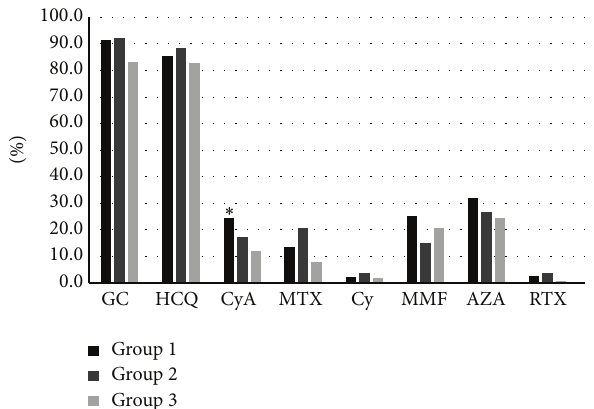
Figure 3: Therapies distribution of the 245 (62.3%) anti-dsDNA + (group 1), 52 (13.3%) anti-dsDNA ± (group 2), and 96 (24.4%) anti- dsDNA − (group 3) SLE patients. ∗ 𝑃 = 0.01 group 1 versus group 2 and group 1 versus group 2.